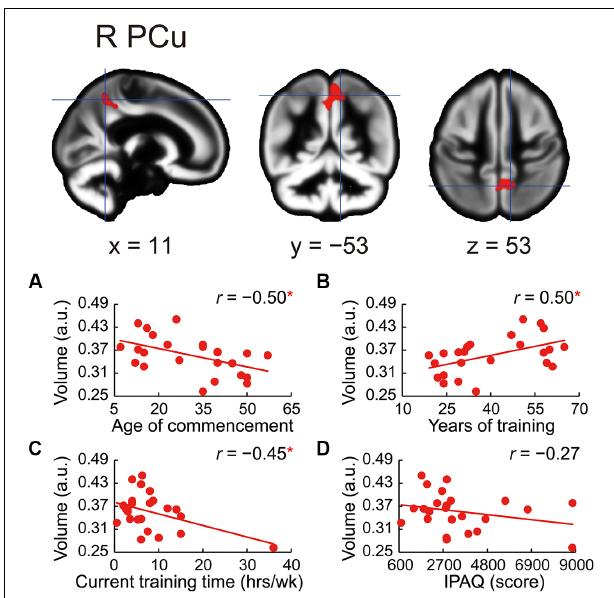
FIGURE 2 | Correlations between precuneus volume and sports traits in the athletes. GMV in the right precuneus was larger in athletes than in non-athletes. Using ROIs in the precuneus, (A) age at the commencement of sports training was negatively correlated with GMV of the precuneus in athletes. (B) GMV of the precuneus was positively correlated with the number of years of sports training in athletes. (C) GMV of the precuneus was negatively correlated with current training time in athletes. (D) No significant correlation between GMV of the precuneus and IPAQ scores in athletes was noted. * P < 0.05, GMV, gray matter volume; ROI, region of interest; R PCu, right precuneus; a.u., arbitrary units; hrs/wk, hours per week; IPAQ, International Physical Activity